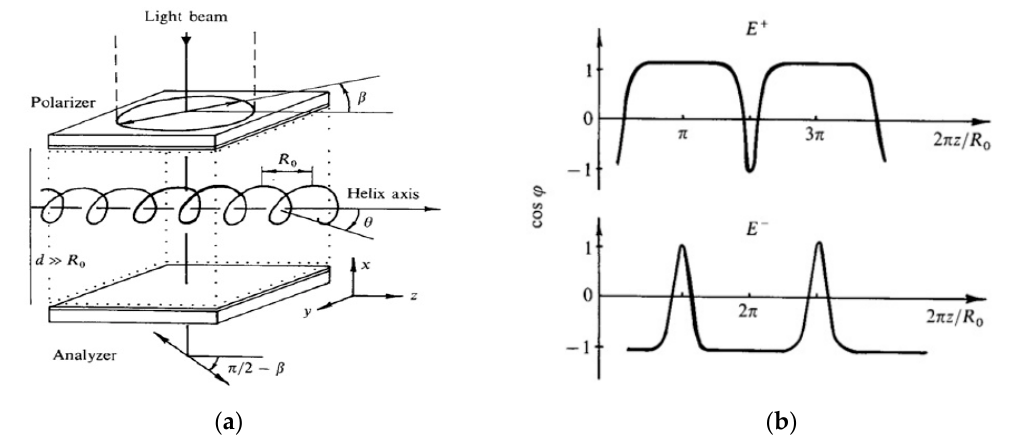
Figure 3. Cell configuration ( a ) and director distribution ( b ) of deformed helix ferroelectric (DHF) cell [20].